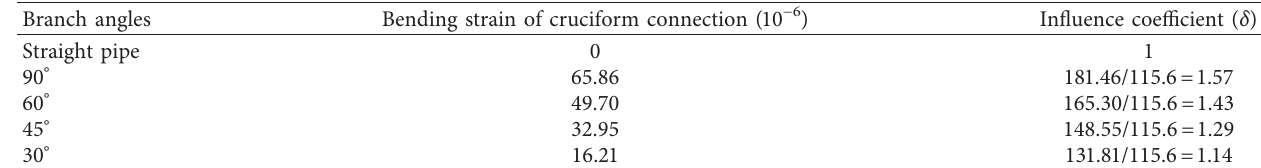
Table 6: Influence coefficients of cruciform connection with different branch